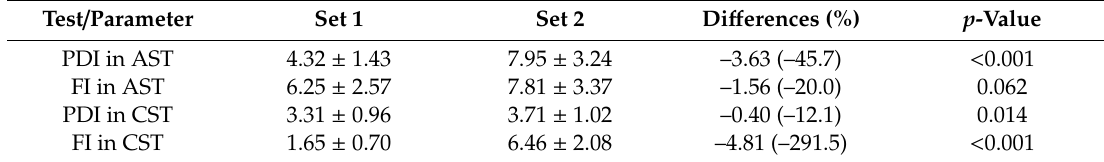
Table 5. Performance decrement index (PDI) and fatigue index (FI) in CST and AST. Test / Parameter